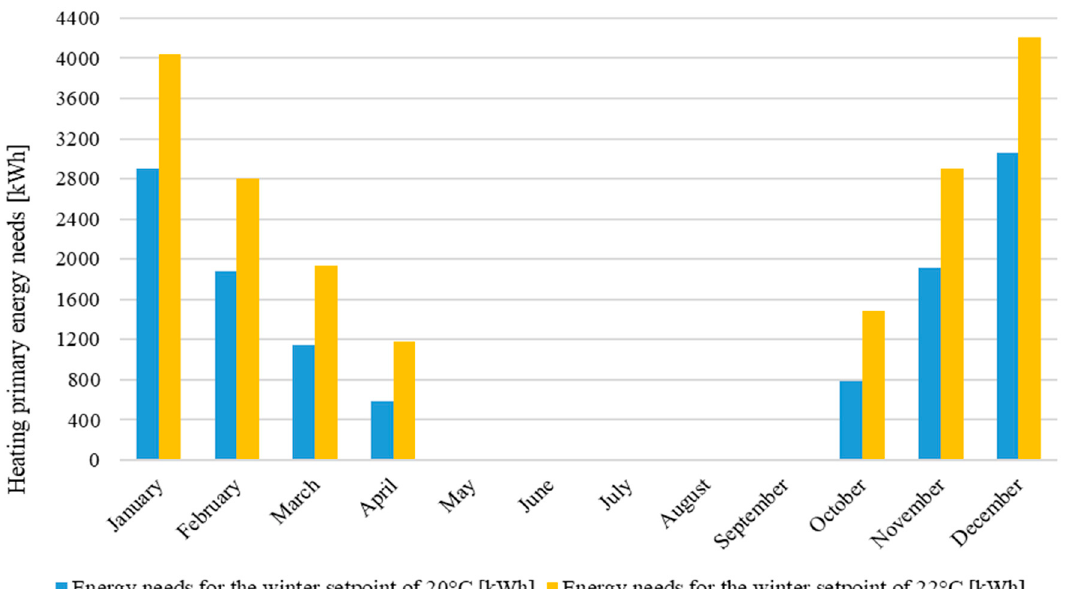
Figure 11. Comparison between the monthly heating primary energy needs for a set point of 20 °C (blue) and 22 °C (yellow).